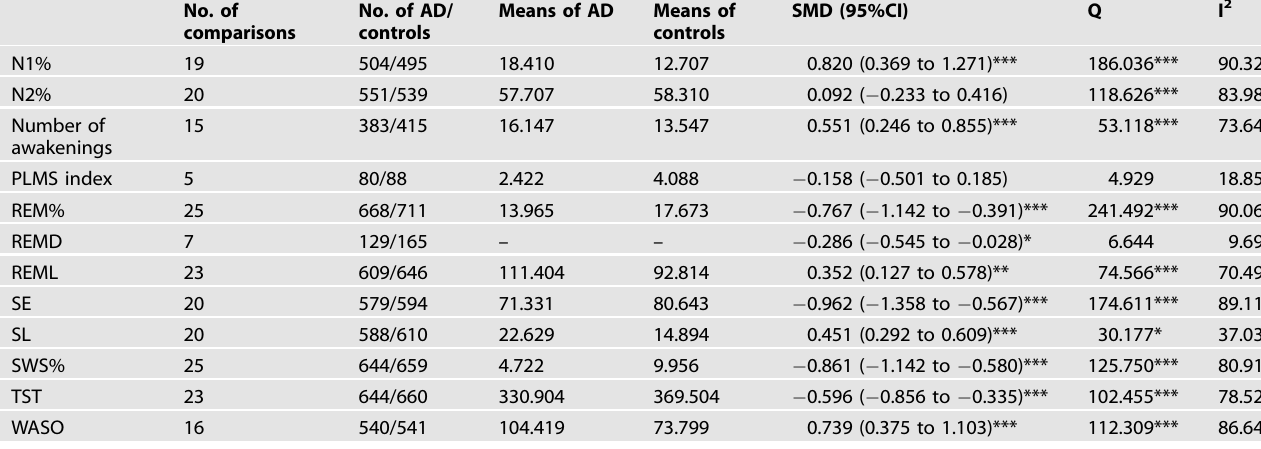
Table 2. Summary of meta-analysis comparing AD patients and